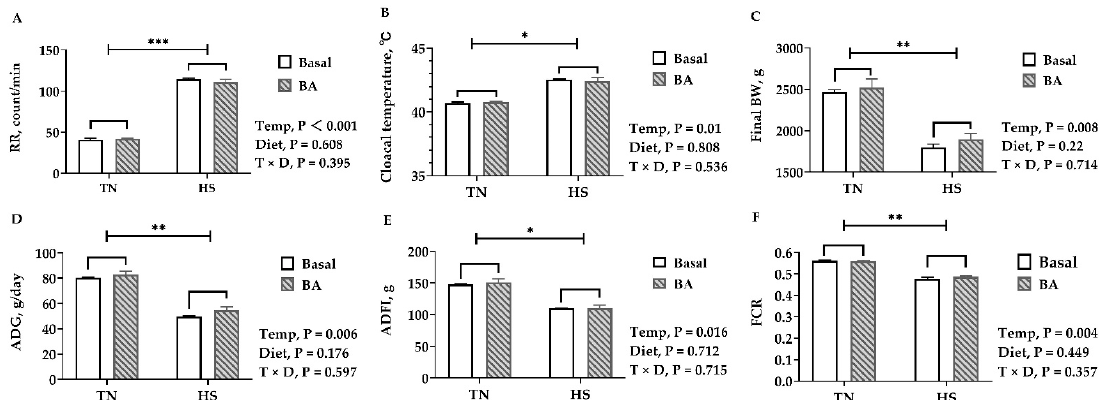
Figure 1. Growth and behavioral performance of broilers fed with 0 or 200 mg/kg bile acids under thermoneutral (TN) and heat-stressed (HS) conditions. ( A ) RR, respiratory rate; ( B ) cloacal temperature on D42; ( C ) final body weight; ( D ) ADG, average daily gain; ( E ) ADFI, average daily feed intake; ( F ) FCR, feed conversion rate. Data are presented as the mean ± SEM (n = 6 for each mean). * p < 0.05, ** p < 0.01, and *** p < 0.001.